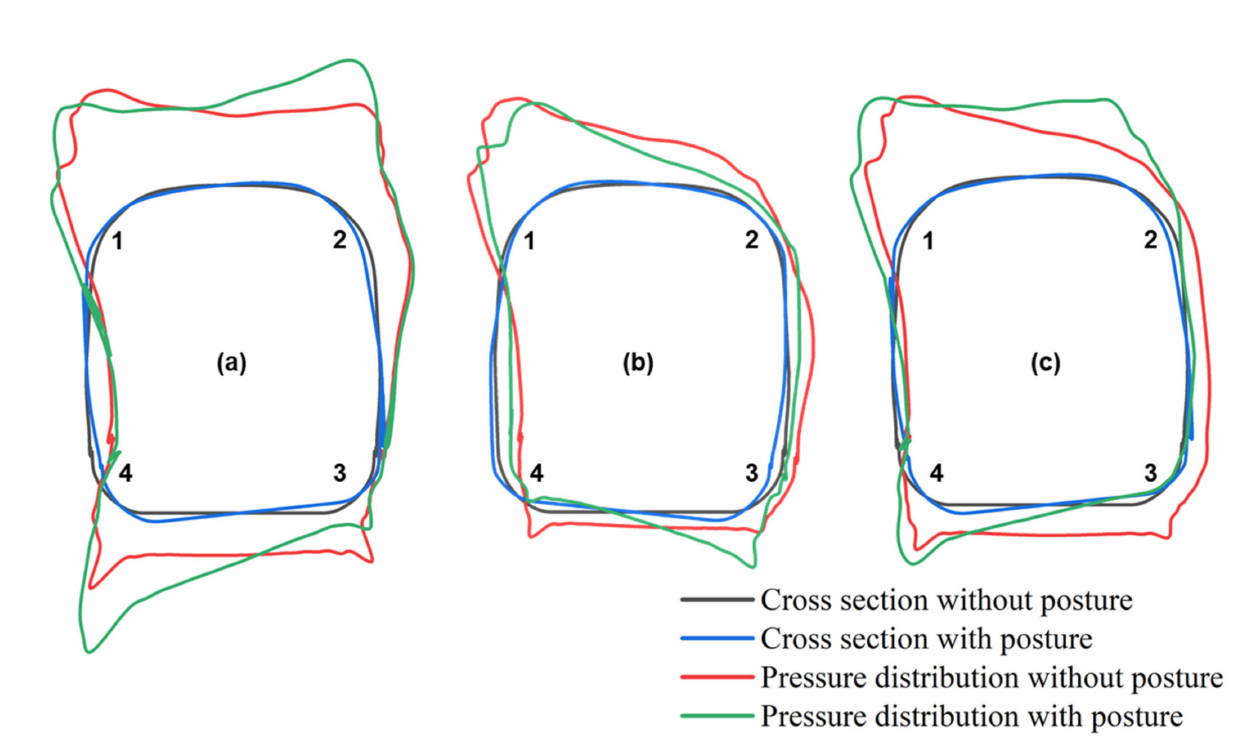
Figure 13. Distribution of C p on the profile of the middle length of: ( a ) leading car; ( b ) middle car; ( c ) trailing